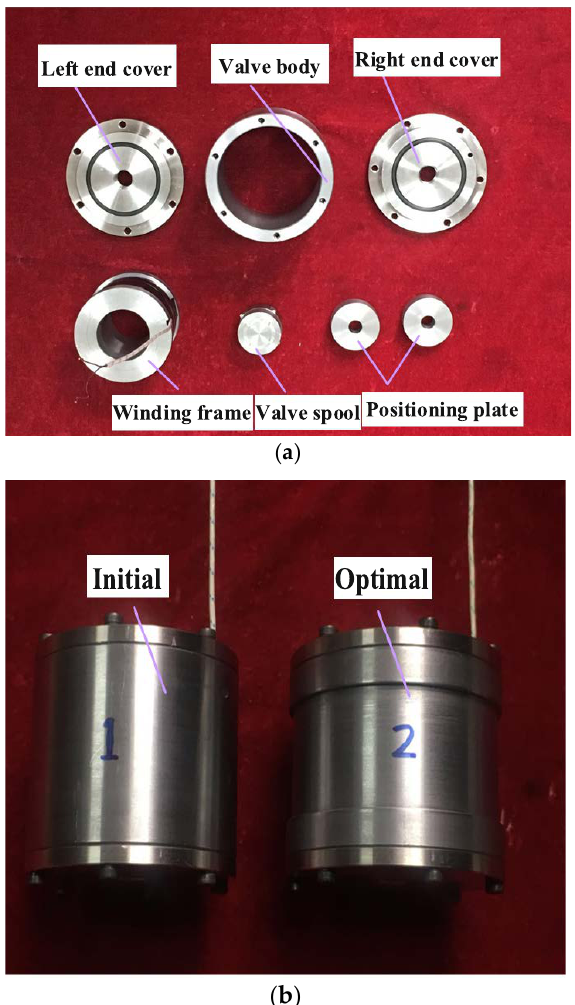
Figure 20. Proto types of the proposed radial MR valve: ( a ) Components, and ( b ) Prototypes. Figure 20. Prototypes of the proposed radial MR valve: ( a ) Components, and ( b )